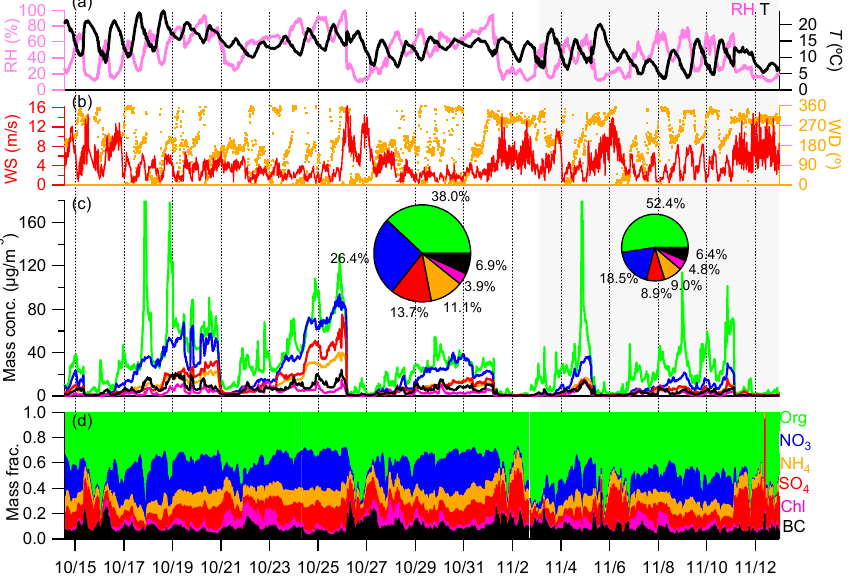
Figure 1. Time series of (a) relative humidity (RH), temperature ( T ) , (b) wind direction (WD), wind speed (WS), (c) mass concentrations, and (d) mass fractions of chemical species in PM 1 . The pie charts show the average chemical composition of PM 1 measured before and during the Asia-Pacific Economic Cooperation (APEC)